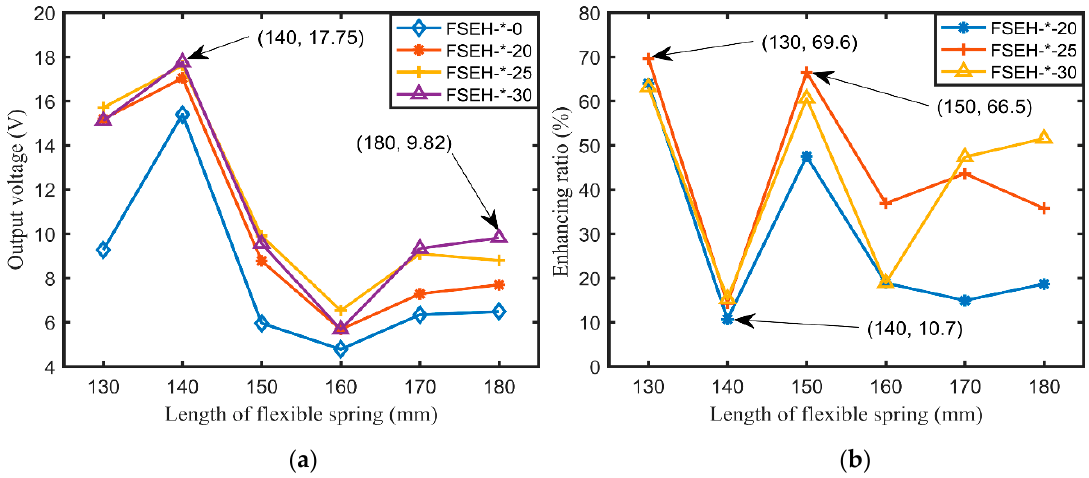
Figure 11. Variation of output voltage and enhancing ratio of FSEH with the length of the flexible spring: ( a ) output voltage; and ( b ) enhancing ratio.